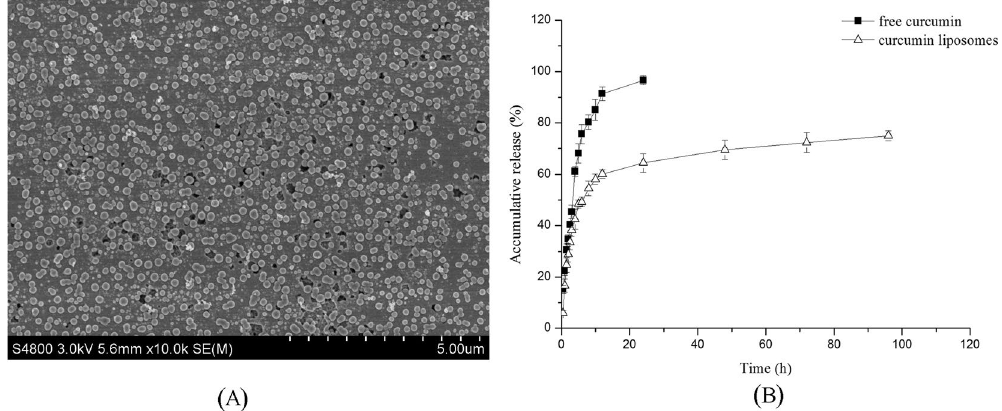
Figure 1. SEM image ( A ) and curcumin release ( B ) of prepared curcumin